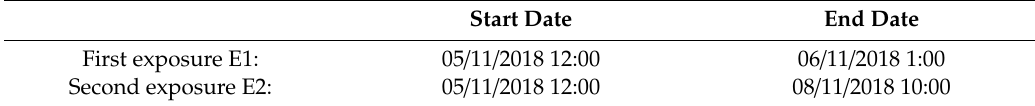
Table 2. Start and end dates for each exposure ((UTC+01:00) Brussels, Copenhagen, Madrid, Paris).